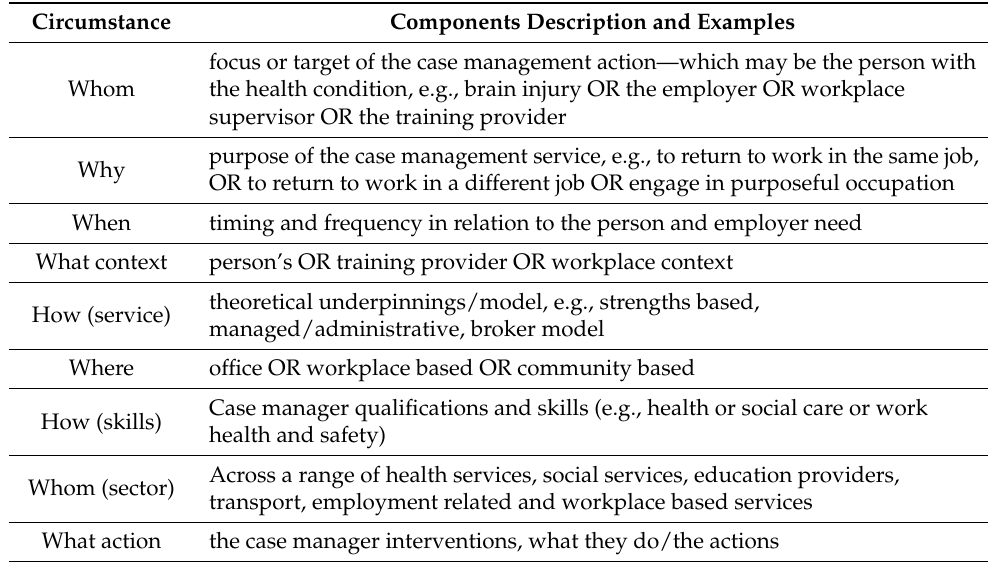
Table 1. The interdependent and dependent components of case management